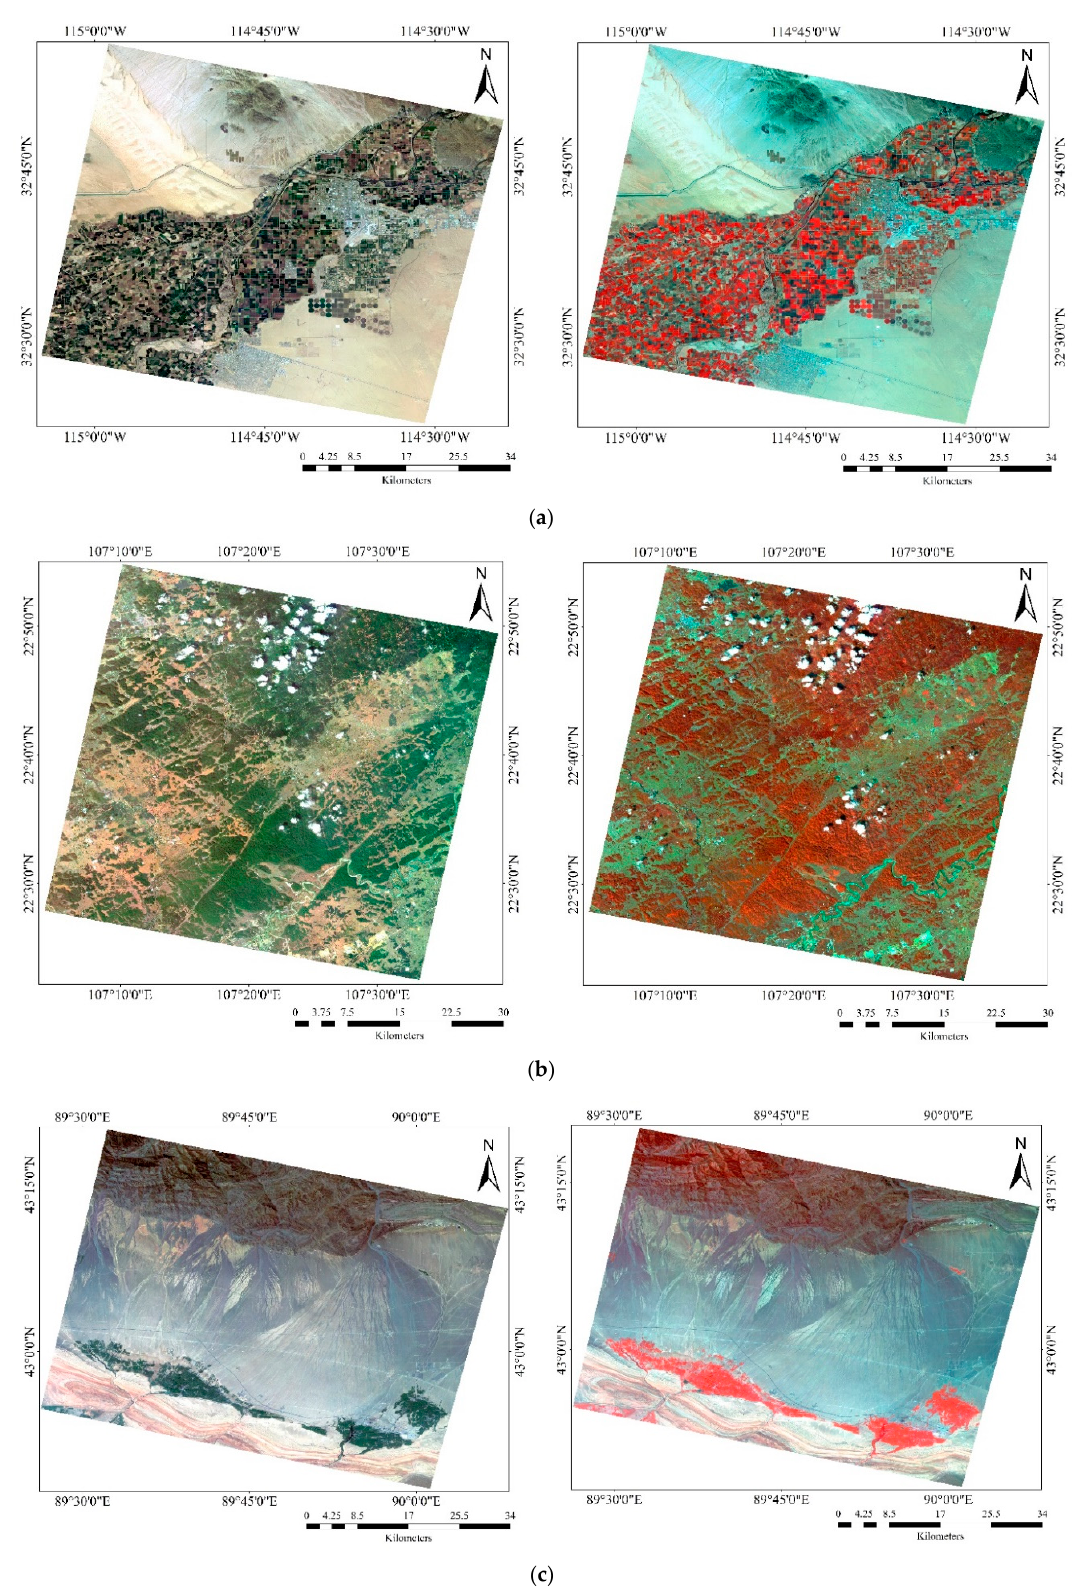
Figure 9. Local comparison of registration results between different bands. ( a ) OHS–Arizona, USA; ( b ) OHS–Guangxi, China; ( c ) OHS–Xinjiang, China.